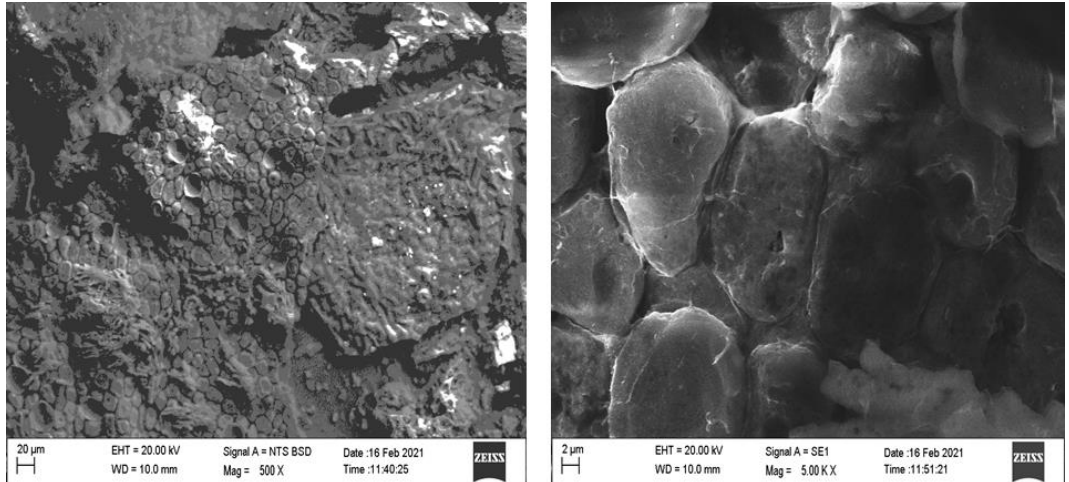
Fig. 3 SEM images of Carbon NPs